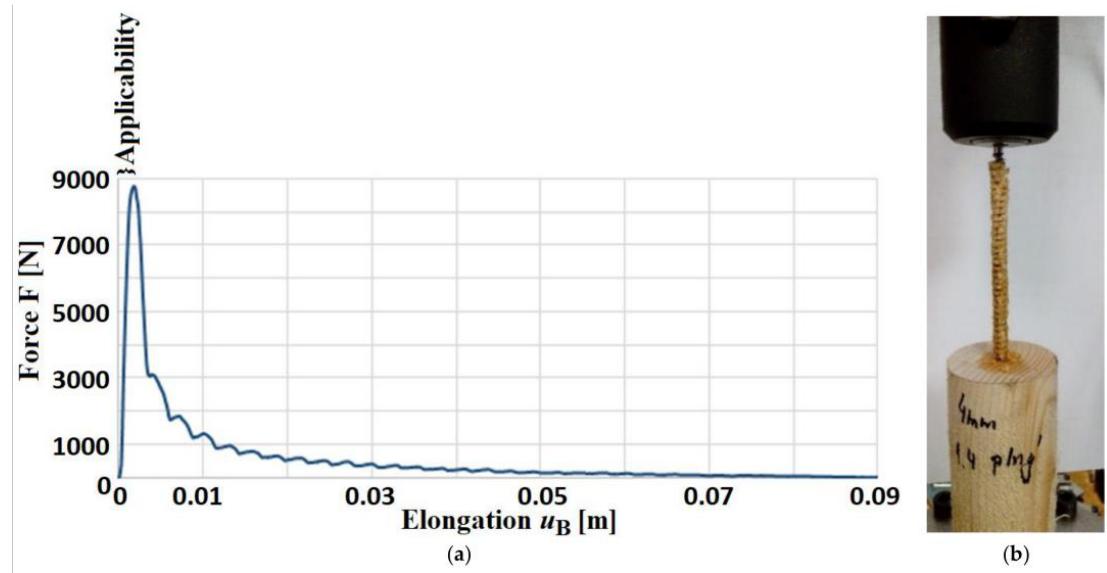
Figure 5. Pull-out test, measurement No. 1. ( a ) Dependence of tensile force F on screw elongation u B ; ( b ) the pulled out screw (end of measurement).